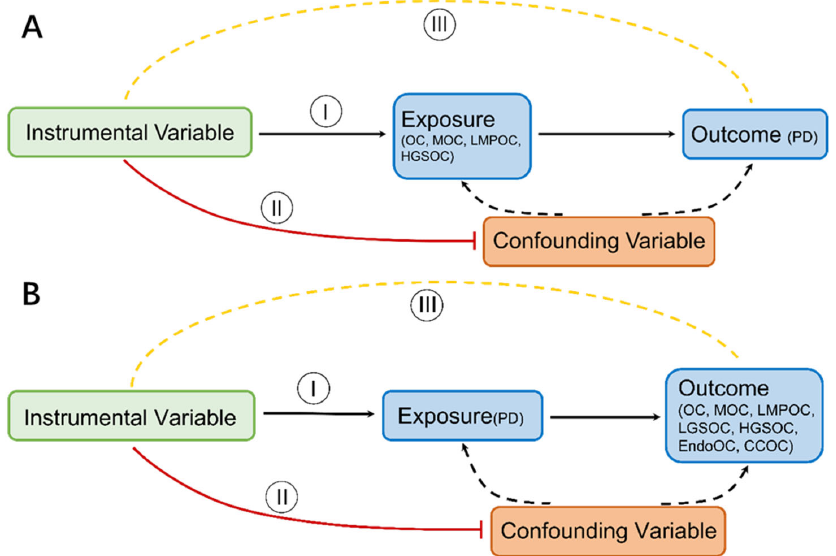
Figure 1. MR concepts and underlying IV assumptions are shown in a directed acyclic graph (I–III). ( A ) OC and its subtypes on the risk of PD ( B ) PD on the risk of OC and its subtypes.